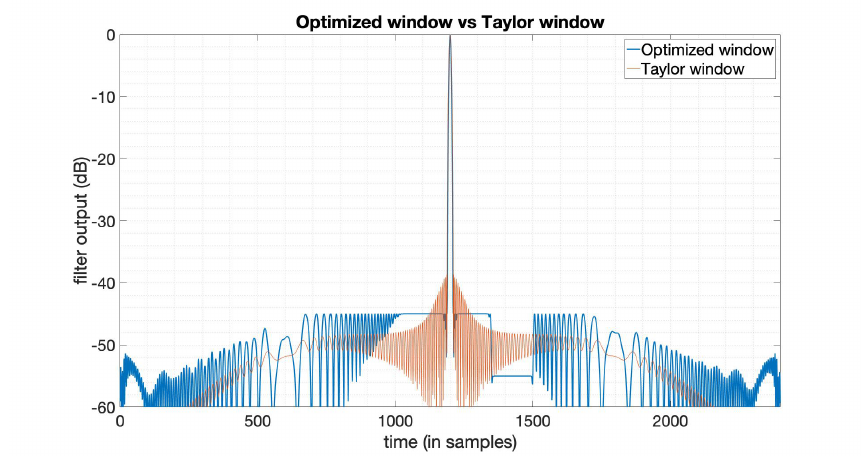
Figure 7. The output of the Taylor window (¯ n = 9,PSLR = − 40 dB) and the SNR loss-optimized window with asymmetric sidelobe gap.